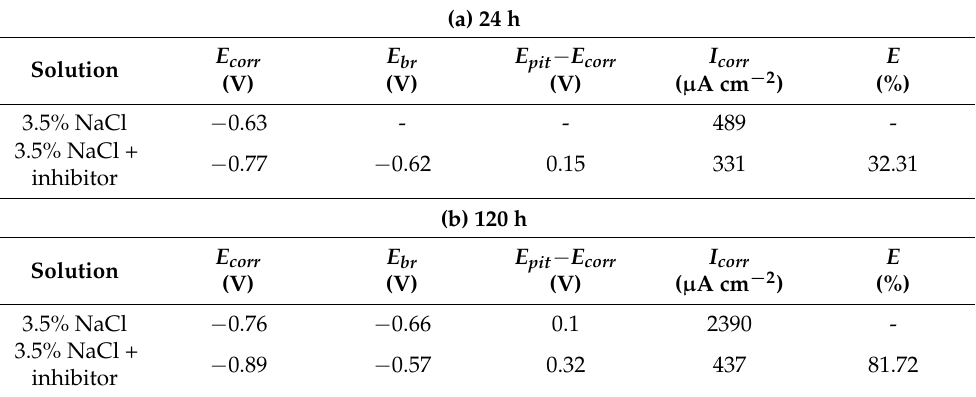
Figure 7. Potentiodynamic polarization curves of AA 2024-T3 in a 3.5% NaCl-containing inhibitor ( a ) at 24 h of immersion time and ( b ) at 120 h of immersion time. Table 2. The potentiodynamic polarization parameters for AA 2024-T3 in a 3.5% NaCl-containing inhibitor ( a ) after 24 h of immersion time and ( b ) after 120 h of immersion time.